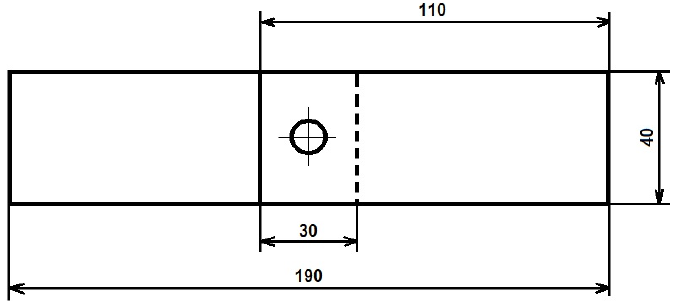
Figure 2. Shape and dimensions of joint assembly in mm.